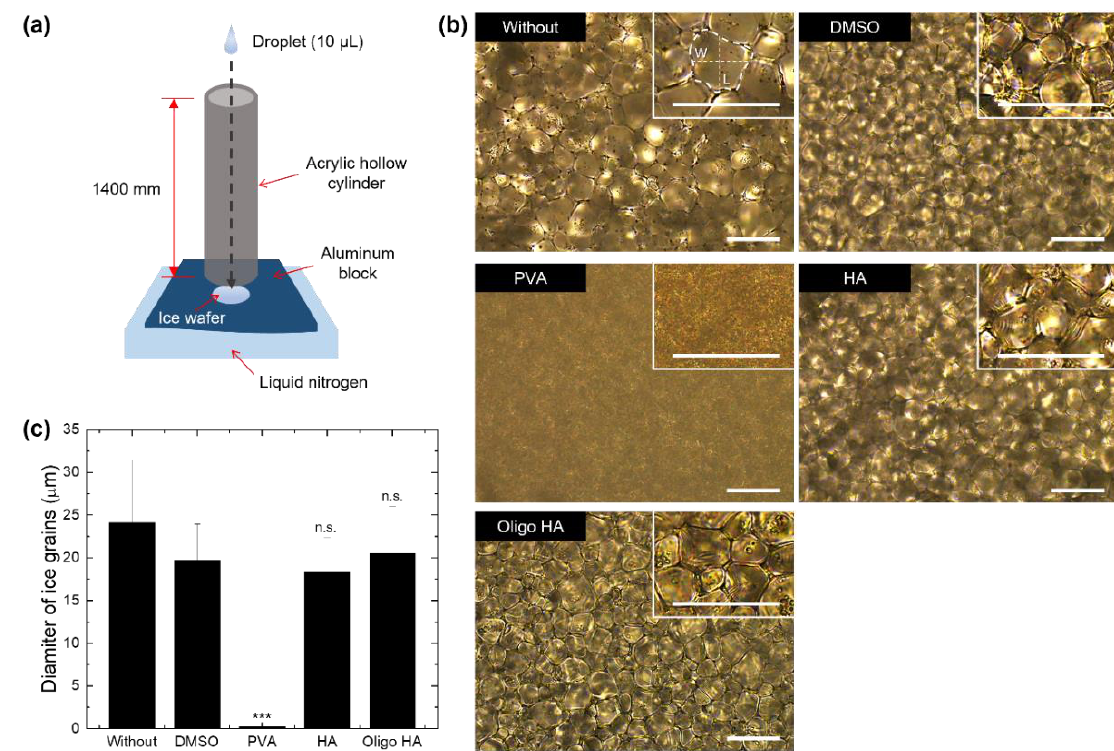
Figure 2. Characterization of ice crystals prepared with cryopreservation media by splat assay. ( a ) Schematic illustration for the experimental set-up of the splat assay. ( b ) Photographs showing the ice grains prepared with different cryopreservation media (frozen DMEM (W/O), with 2.5% DMSO (DMSO) or 10 mg/mL PVA, HA, or oligo-HA). The samples were annealed at −8 °C for 30 min in a splat- cooling chamber. (Scale bar: 50 μm) ( c ) The graph shows the average diameter of ice grains measured from images in Figure 2a. The data represent the mean ± S.D. *** p < 0.001 vs. DMSO. n.s. indicates no significance.